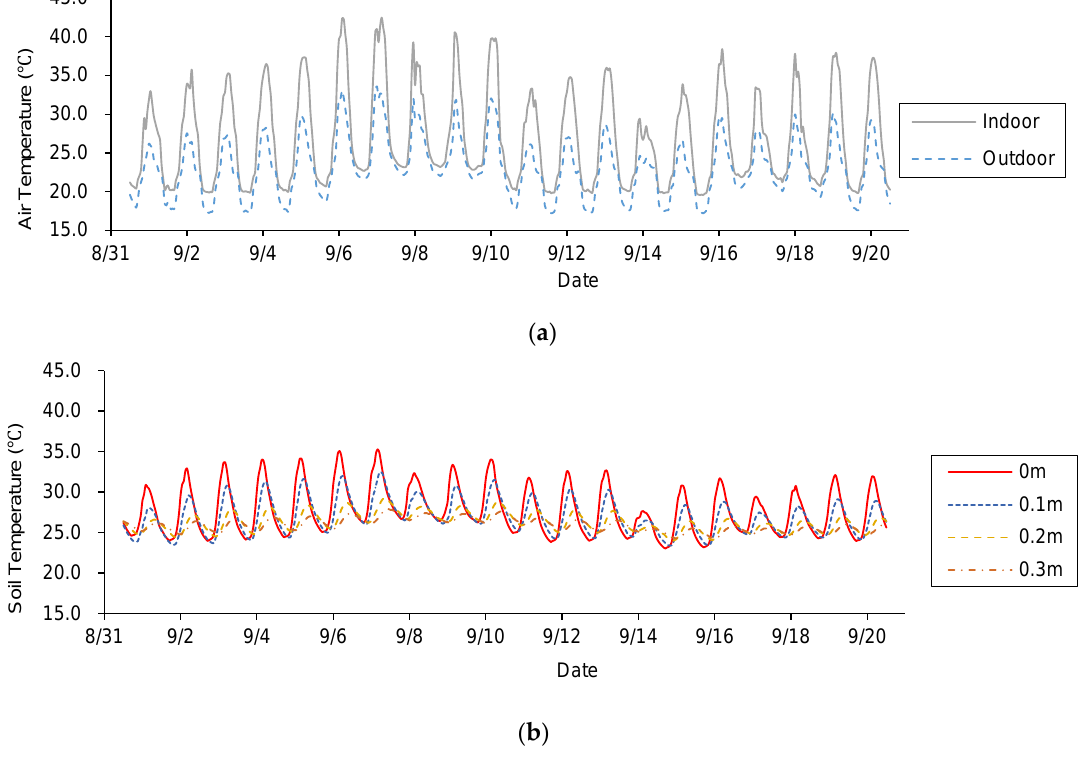
Figure 1. Diurnal variation of greenhouse air temperature ( a ) and greenhouse soil temperature ( b ) during the cooling season.